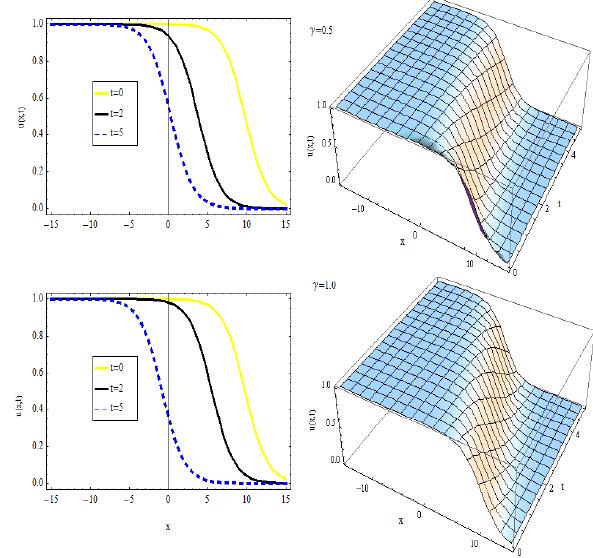
Figure 1: Graphs of (11) for conformable time-fractional Cahn-Allen